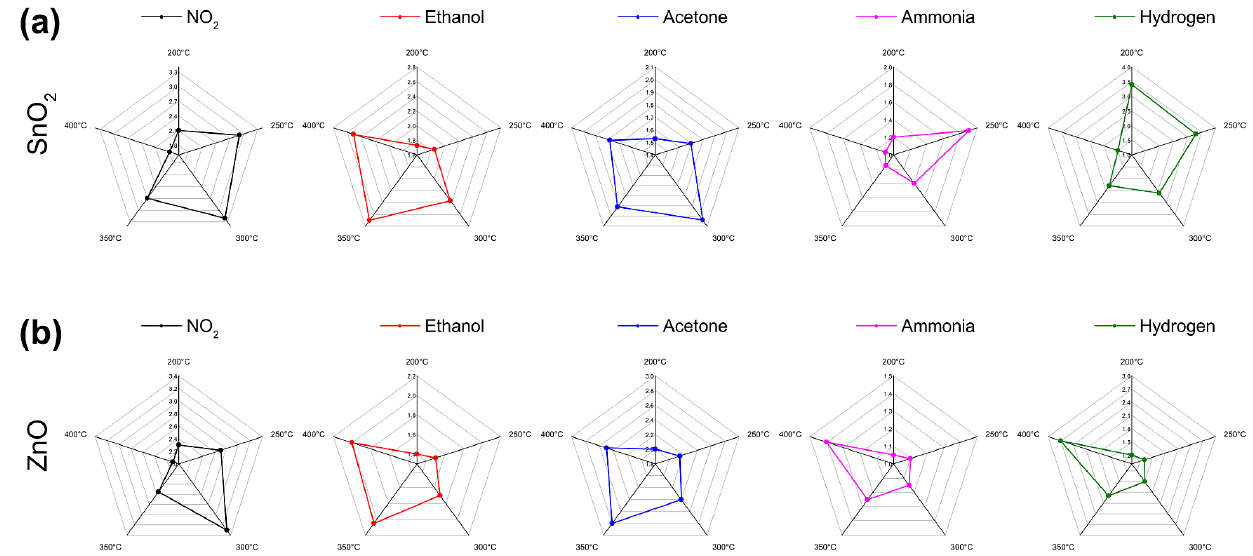
Figure 4. Radar plots obtained by measuring 100 ppm of each gas at five temperatures: ( a ) with the sensor based on SnO 2 nanowires; ( b ) with the sensor based on ZnO nanowires.